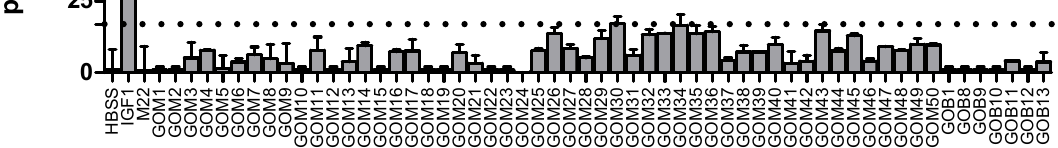
Figure 4. IGF1Rs are not activated by GO-Igs in Graves’ orbital fibroblasts. IGF1, the human monoclonal antibody M22 and 57 GO-Ig preparations were used to determine whether GO-Igs stimulated the phosphorylation of IGF1R in GOFs. Rapid autophosphorylation of IGF1R is the main initiator of IGF1R signaling. As expected, IGF1 stimulated a robust increase in phospho-IGF1R, but M22 had no effect. None of the 57 GO-Ig preparations tested increased phospho-IGF1R. Reprinted from [11] .